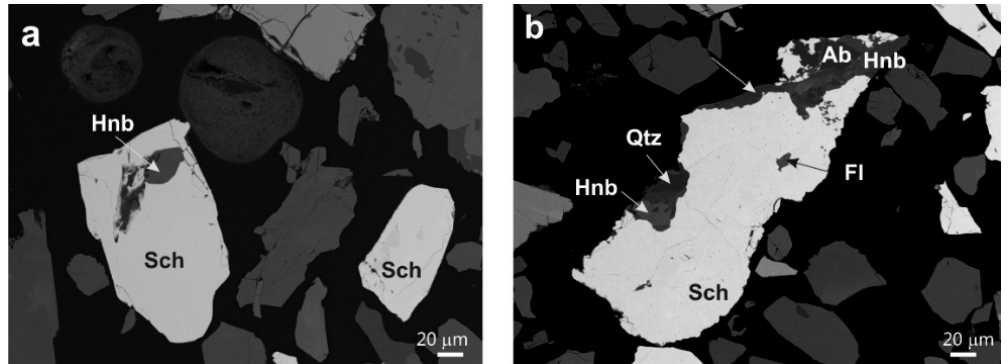
Figure 2. SEM-BSE images of the scheelite concentrate: ( a ) binary particle of scheelite and hornblende, and ( b ) multi-component particle. Sch, Scheelite; Hnb, hornblende; Qtz, quartz; Ab, albite; Fl, fluorite.